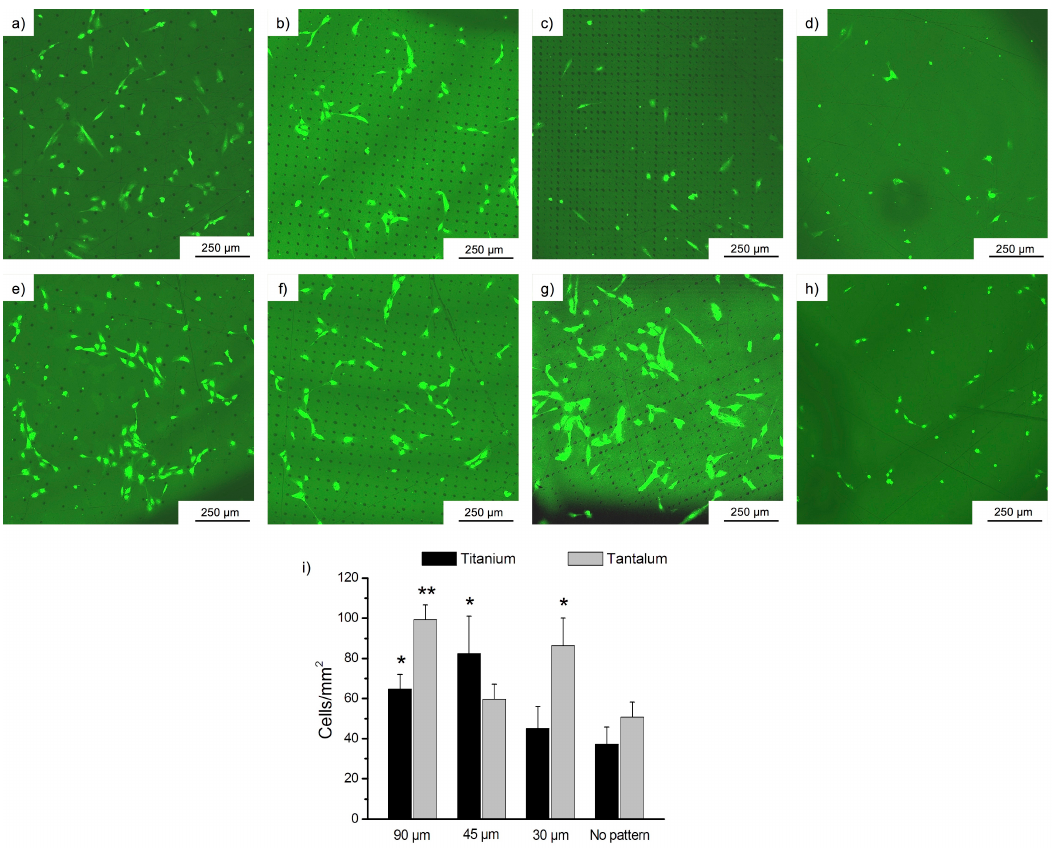
Figure 9. Images achieved by fluorescence microscopy of the endothelial cells over the different patterns after 17 h culture. Figures ( a – c ) show the cells attachment over titanium when the period of the structure is 90, 45, and 30 µ m, respectively; In figures ( e – g ), we can see the cells spread on structured tantalum with periods 90, 45, and 30 µ m, respectively; Figures ( d , h ) correspond to non-structured titanium and tantalum, respectively; Figure ( i ) shows a histogram that represents the number of cells per mm 2 of material (mean ± standard error of the mean in vertical bars) over the different structured and non-structured surfaces. * p < 0.05 and ** p < 0.005 with respect to non-patterned surfaces.